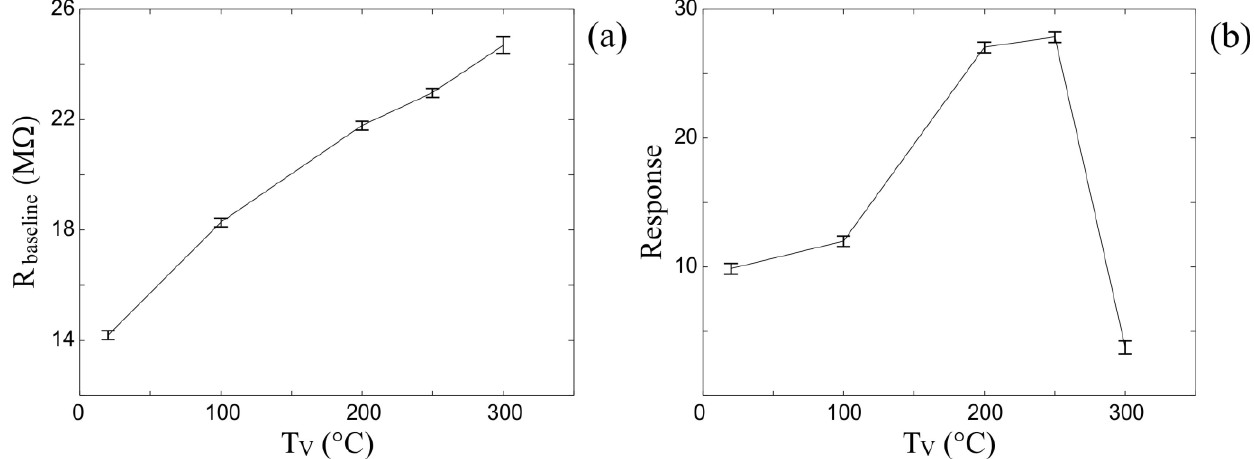
Figure 6. ( a ) The average baseline resistance of the xenon light bulb ZnO nanospring sensor (T = 435 °C) at different vapor gas mixture temperatures T LB change in the chemiresistor response to 1,000 ppm toluene vapor at different vapor gas mixture temperatures T (T = 435 V LB